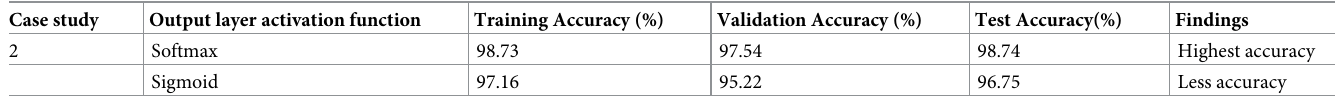
Table 10. Performance analysis by changing output layer activation function.